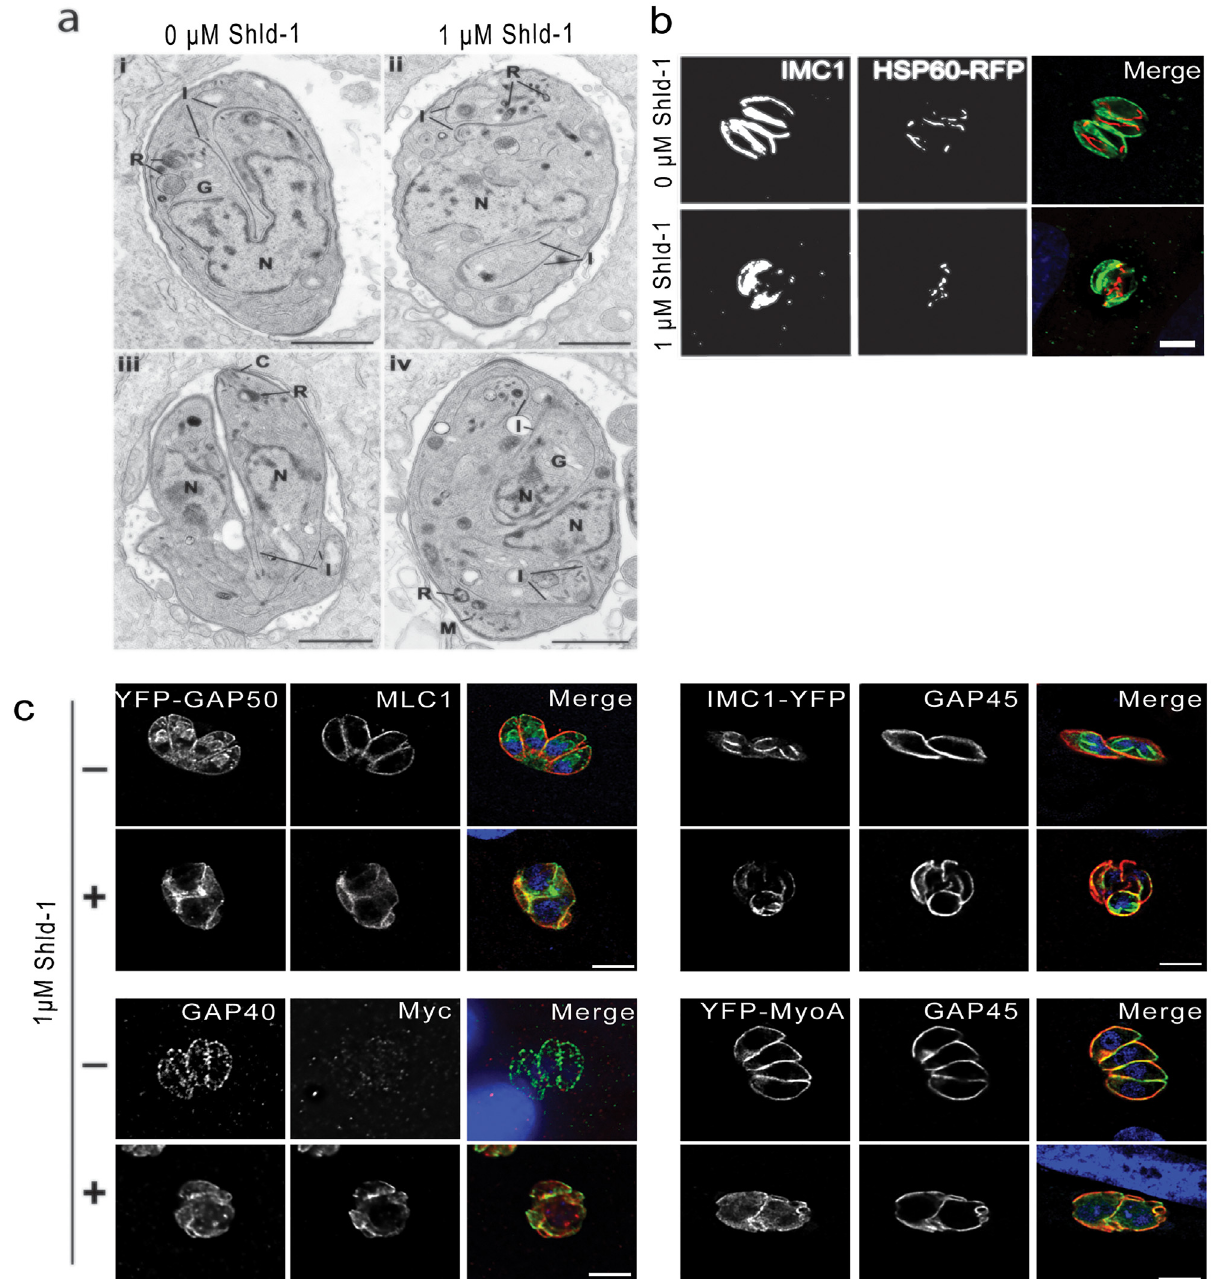
Fig 1. Overexpression of MyoA tail leads to morphological disruption of the parasite ’ s structure. MyoA tail -expressing parasites were treated with 1 μ M Shld-1 and fixed after 24 h. (a) Electron microscopy of ddMyc-MyoA tail untreated (i, iii) or treated with 1 μ M Shld-1 (ii, iii) for 24 h. ( i ) Longitudinal section of a cell undergoing endodyogeny showing the conical shaped IMC (I) of the two daughters enclosing the dividing nucleus (N). ( ii ) Section showing an enlarged nucleus (N) with the cytoplasm containing partially disorganised plates of IMC (I). ( iii ) Late stage in endodyogeny showing the folding of the plasmalemma to form the pellicle of the daughters. ( iv ) Section showing a parasite with multiple nuclei (N) and the cytoplasm contain a number of partially formed daughters. C — conoid; G — Golgi body; I — IMC; R — rhoptries; M — Microneme. Scale bar 1 μ m. ( b ) MyoA tail -expressing parasites co-expressing mitochondrial marker hsp60-rfp were stained using anti-IMC1. Overexpression of MyoA tail resulted in an alteration of mitochondrial morphology. ( c ) The localisation of components of the motor complex was analysed using specific antibodies (MLC1, GAP40, GAP45) or co-expression of YFP-tagged constructs ( yfp-gap50 , imc1-yfp , yfp- myoA ). MyoA tail expression, as visualised using a specific antibody against the epitope tag Myc, resulted in a severe defect in parasite morphology, however glideosome components remained at the periphery of the mother cell. Scale bar 10 μ m.